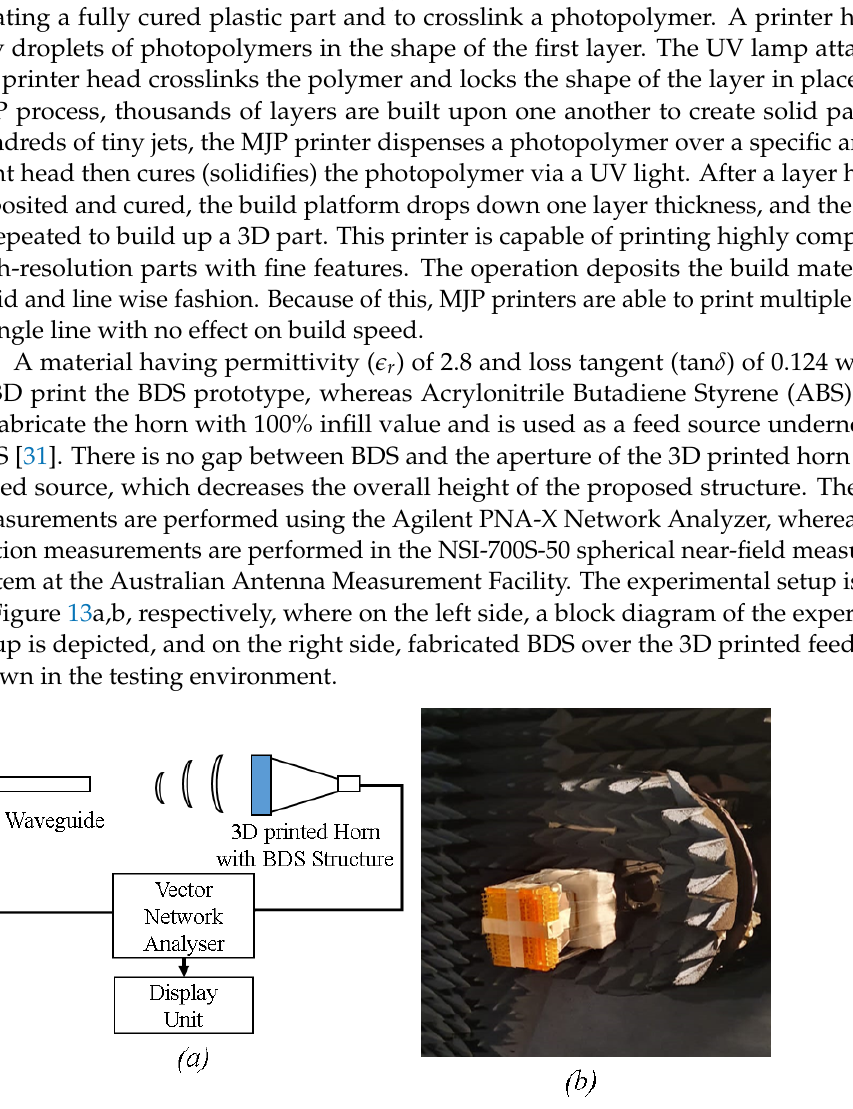
Figure 13. Block diagram with fabricated BDS prototype. ( a ) System setup block diagram. ( b ) Fabri- cated BDS prototype connected to 3D printed horn antenna as set up in a measurement